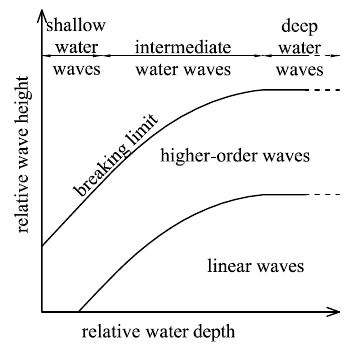
Figure 9. Schematic representation of the different wave-theory regimes for varying water depths and wave heights.